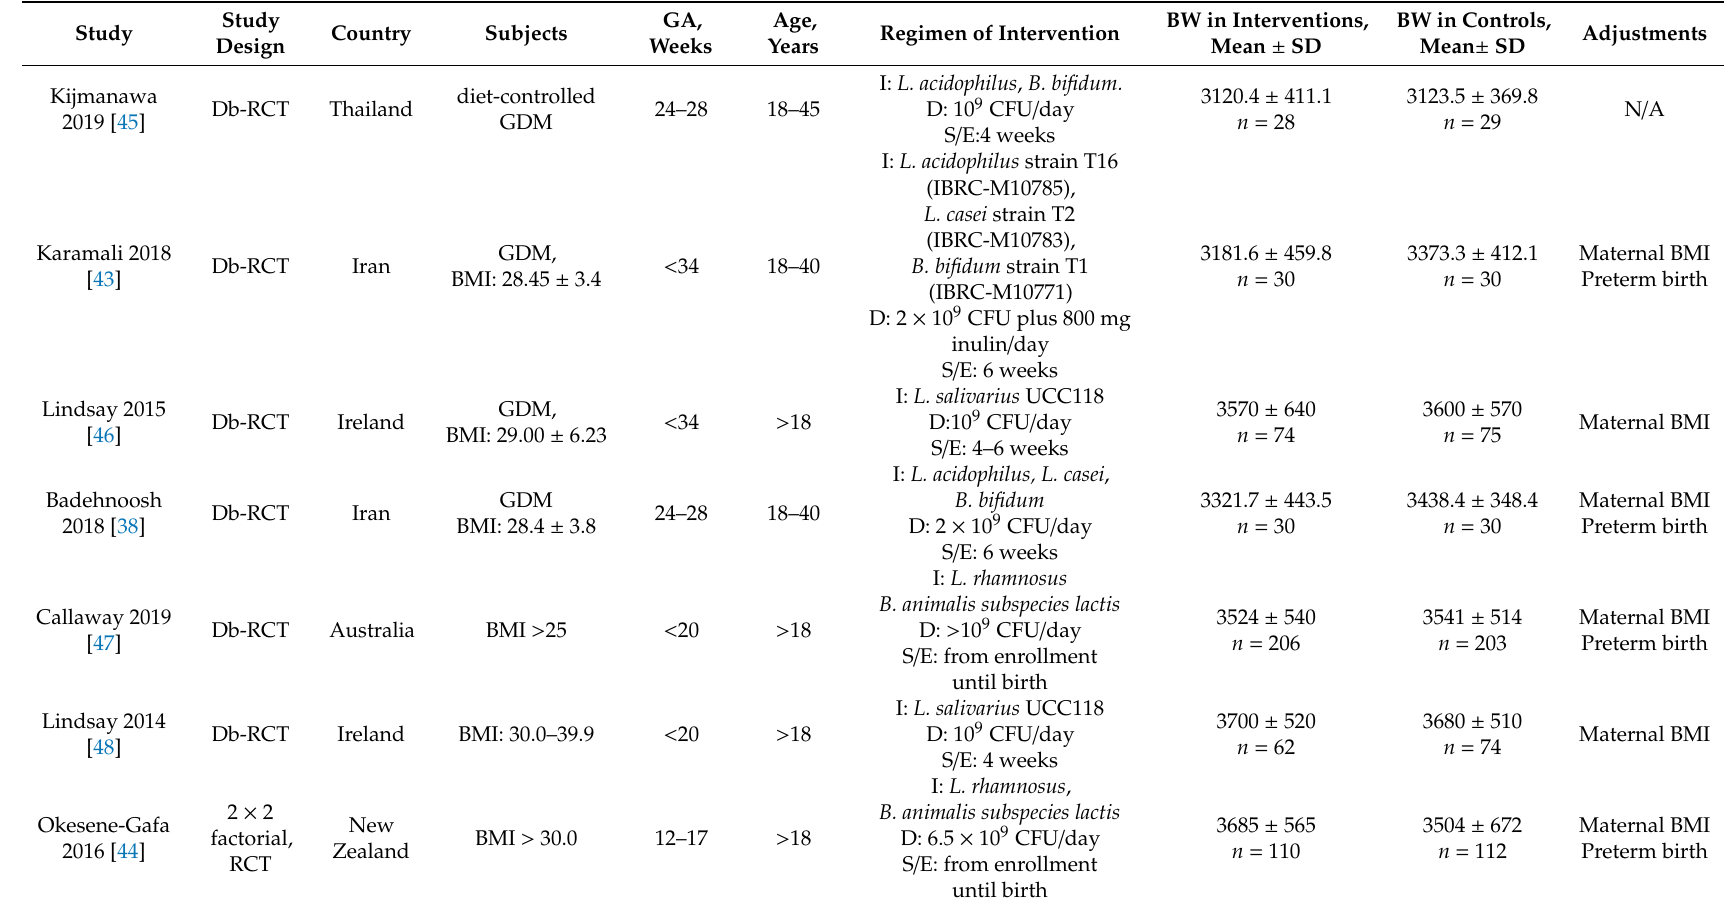
Table 1. Characteristics of the included